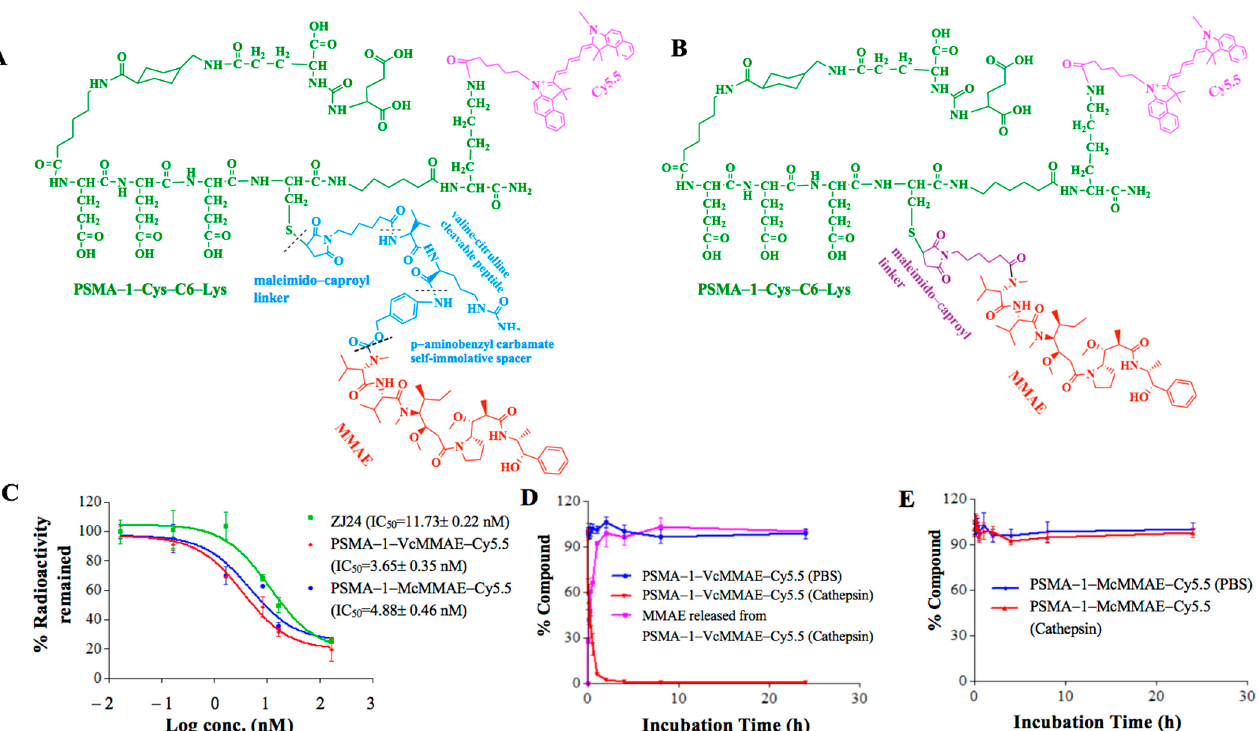
Figure 1. Novel Prostate specific membrane antigen (PSMA)-targeted drug conjugates. ( A ) Structure of PSMA-1-VcMMAE-Cy5.5 which has a cleavable linker (in blue color). ( B ) Structure of PSMA-1-McMMAE-Cy5.5 which has a noncleavable linker (in purple color). ( C ) In vitro competition binding results of PSMA-targeted drug conjugates. Values are mean ± SD of triplicates. PSMA-1-VcMMAE-Cy5.5 and PSMA-1-McMMAE-Cy5.5 showed similar binding affinity. ( D ) In vitro cathepsin cleavage of PSMA-1-VcMMAE-Cy5.5. Values are mean ± SD of triplicates. ( E ) In vitro cathepsin cleavage of PSMA-1- McMMAE-Cy5.5. Values are mean ± SD of